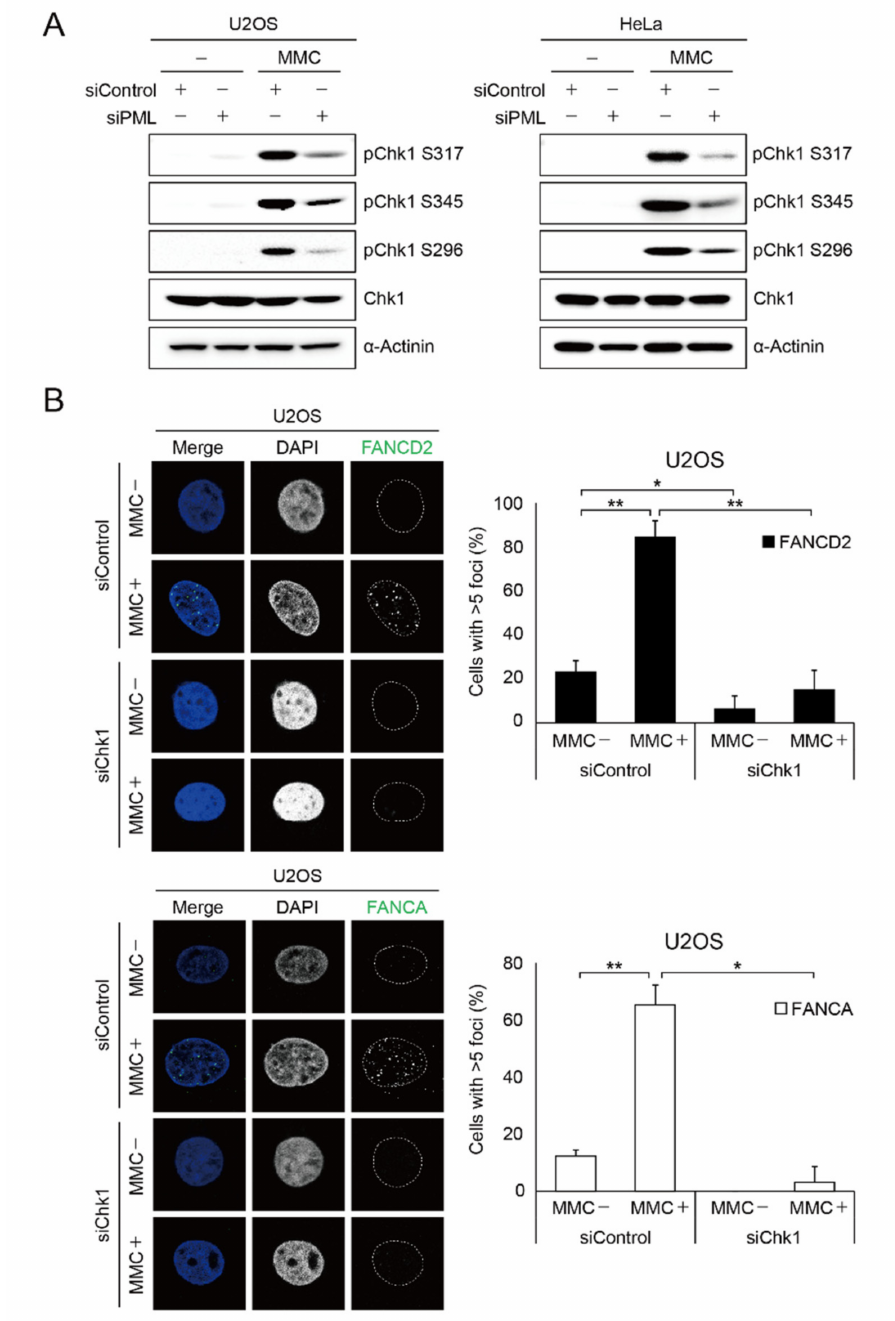
Figure 4. Depletion of PML impairs phosphorylation of CHK1 in response to DNA damage. ( A ) Phos- phorylation of CHK1 in U2OS and HeLa cells treated with si PML in the absence or presence of 1 µ M MMC. ( B ) U2OS cells treated with CHK1 siRNA were immunostained by anti- FANCD2 or anti- FANCA antibody in the absence or presence of 1 µ M MMC exposure. Representative immunoflu- orescence images and their quantification are shown. Over 37 nuclei were counted for statistics. Data represent the mean ± SD from three independent experiments (** p < 0.01; * p <